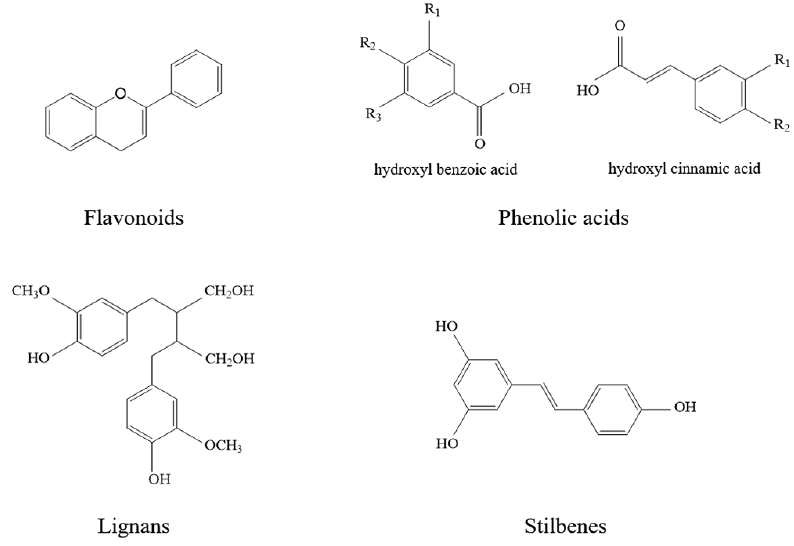
Antioxidants 2021 , 10 , x